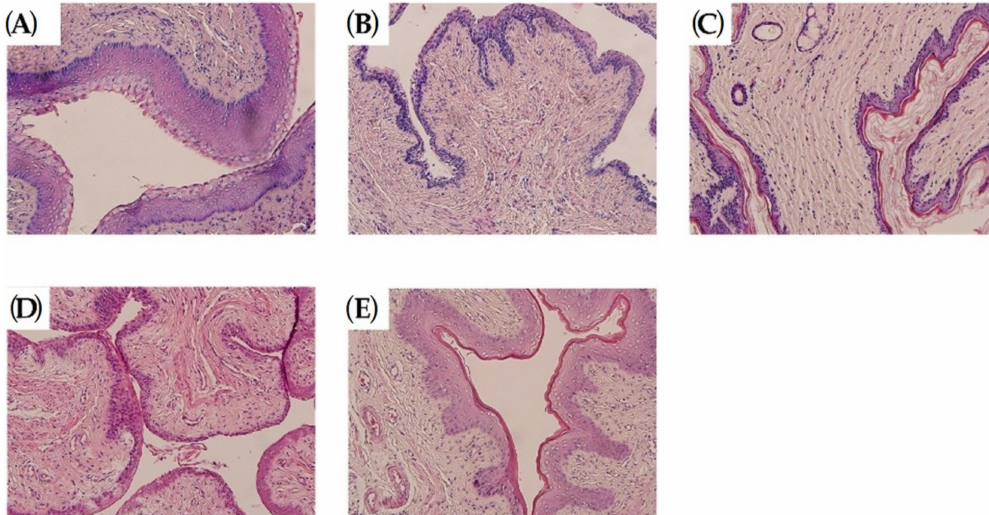
Figure 2. ( A ) HE stain of vagina of Sham group rats with normal morphology, (40X). ( B ) HE staining of the vagina of group M rats with significant atrophy of the vaginal wall, (40X). ( C ) HE staining of the vagina of rats in group K has not significantly different from those in group M, (40X). ( D ) HE staining of the vagina of rats in group Y showed a mild improvement in atrophy compared to group M, (40X). ( E ) HE staining of the vagina of rats in the Gen group showed a significant improvement in atrophy compared to the M group,